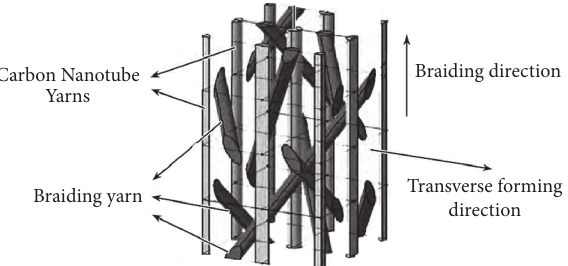
Figure 3: Prefabricated part structure of the 3D five-directional braided